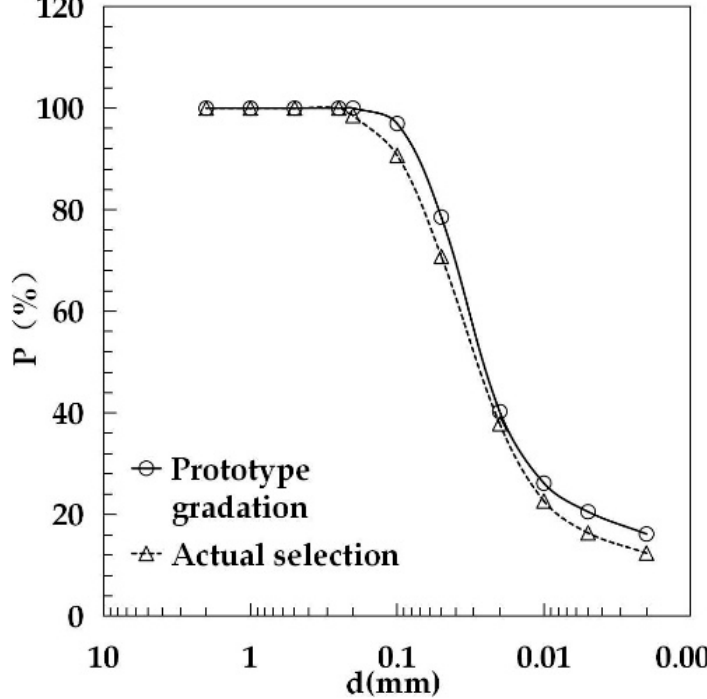
Figure 2. The sediment particle grading curves of the model and prototype.